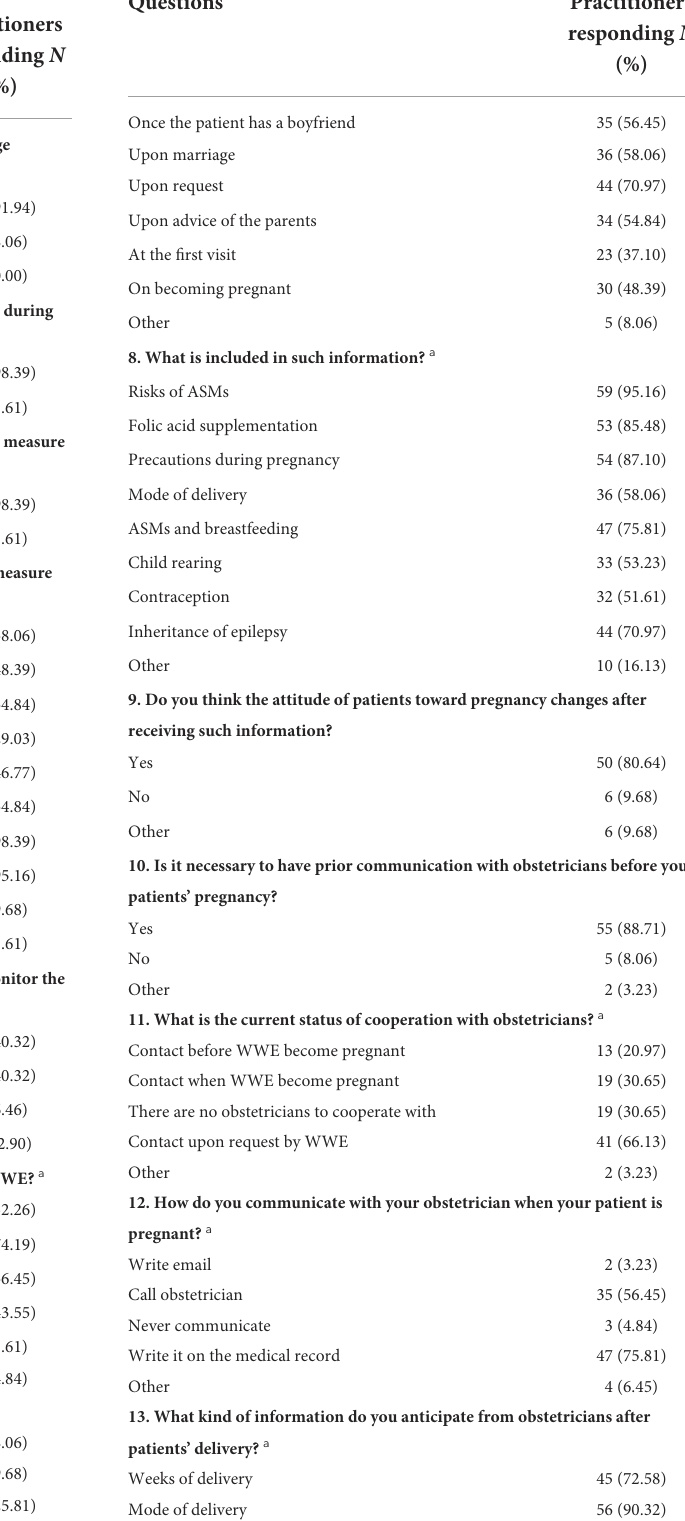
TABLE 3 Management practices and barriers in epilepsy during